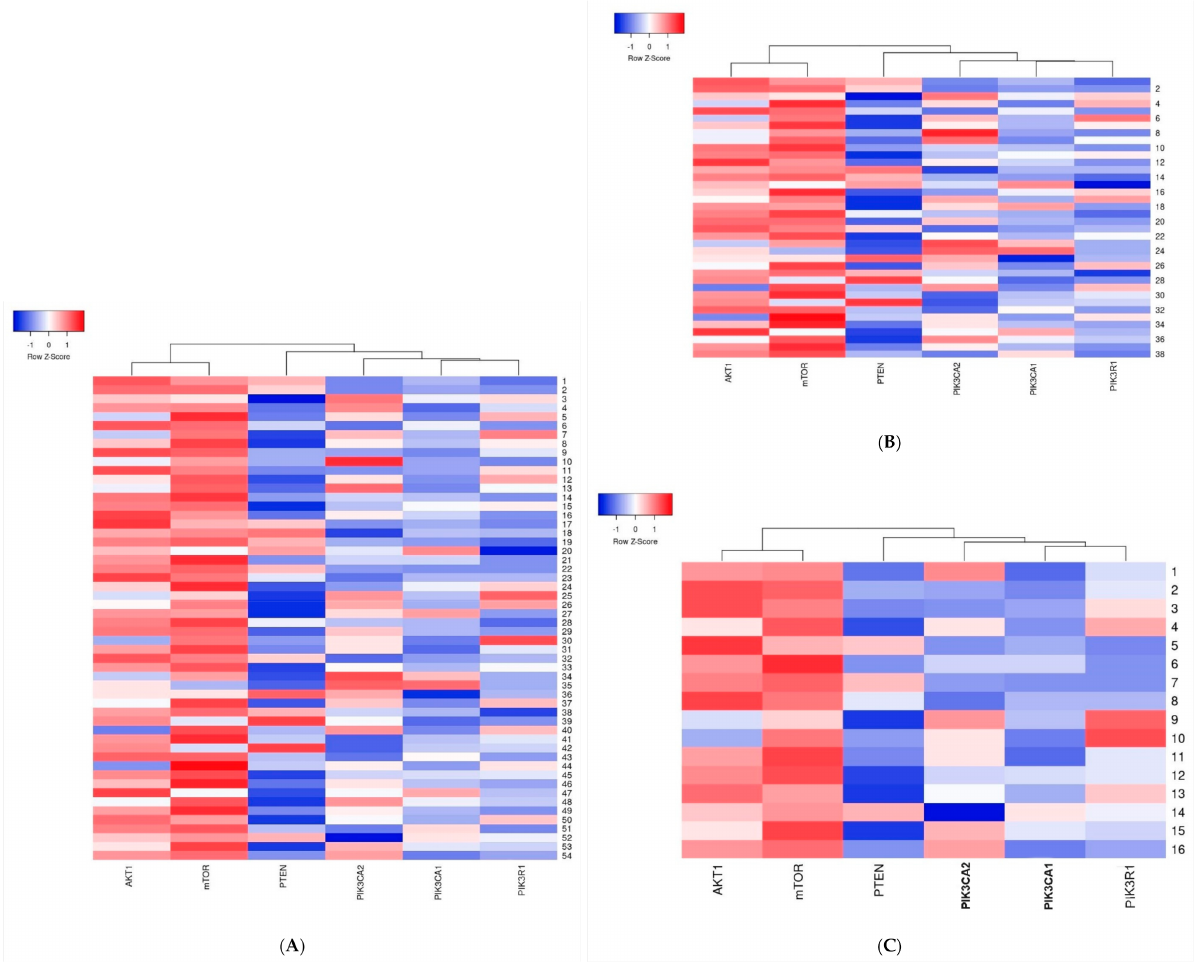
Figure 7. Heatmap presenting a clustering analysis of the expression level of the studied genes (clustering method: average linkage; Euclidean distance measurement method): ( A ) in the entire studied group; ( B ) in the group of patients without mutations; ( C ) in the group of patients with